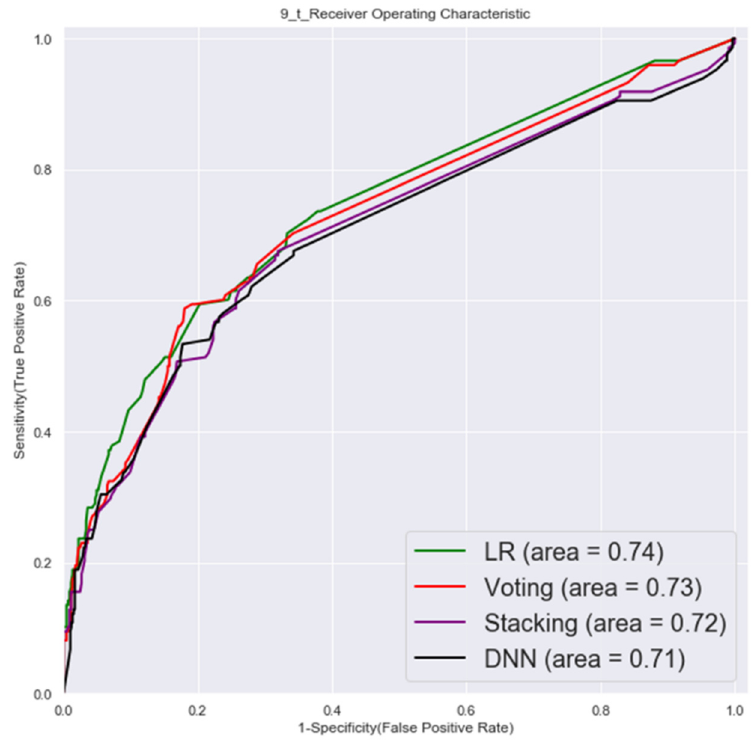
Figure 8. Testing set ROC (third factor combinations).